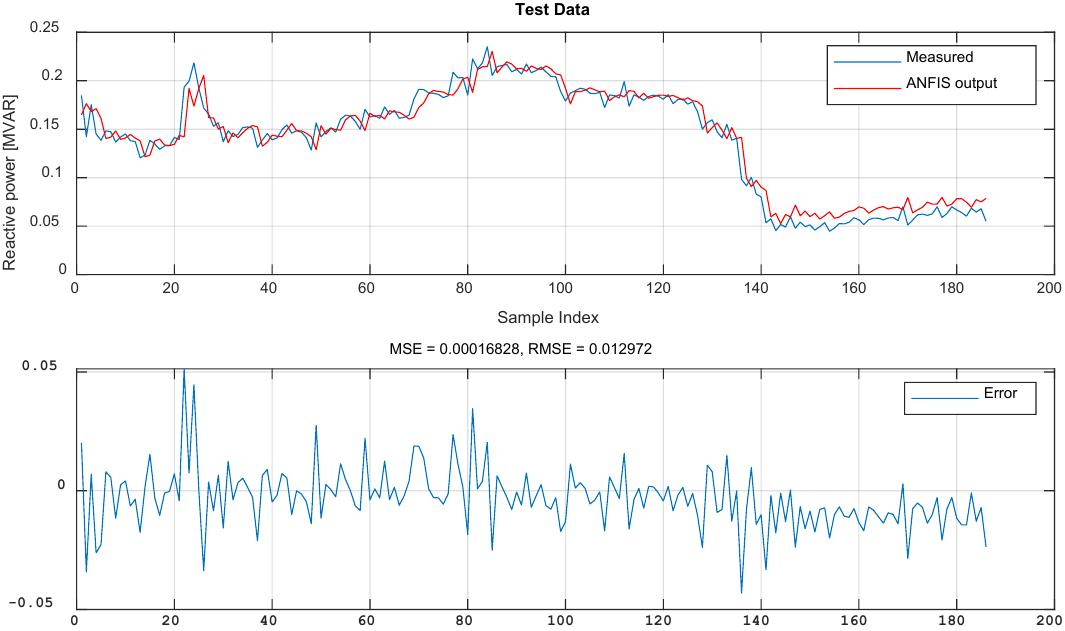
Figure 8. The variation in the measured and predicted reactive power and also of the error for modelling with ANFIS grid partition method for training stage.